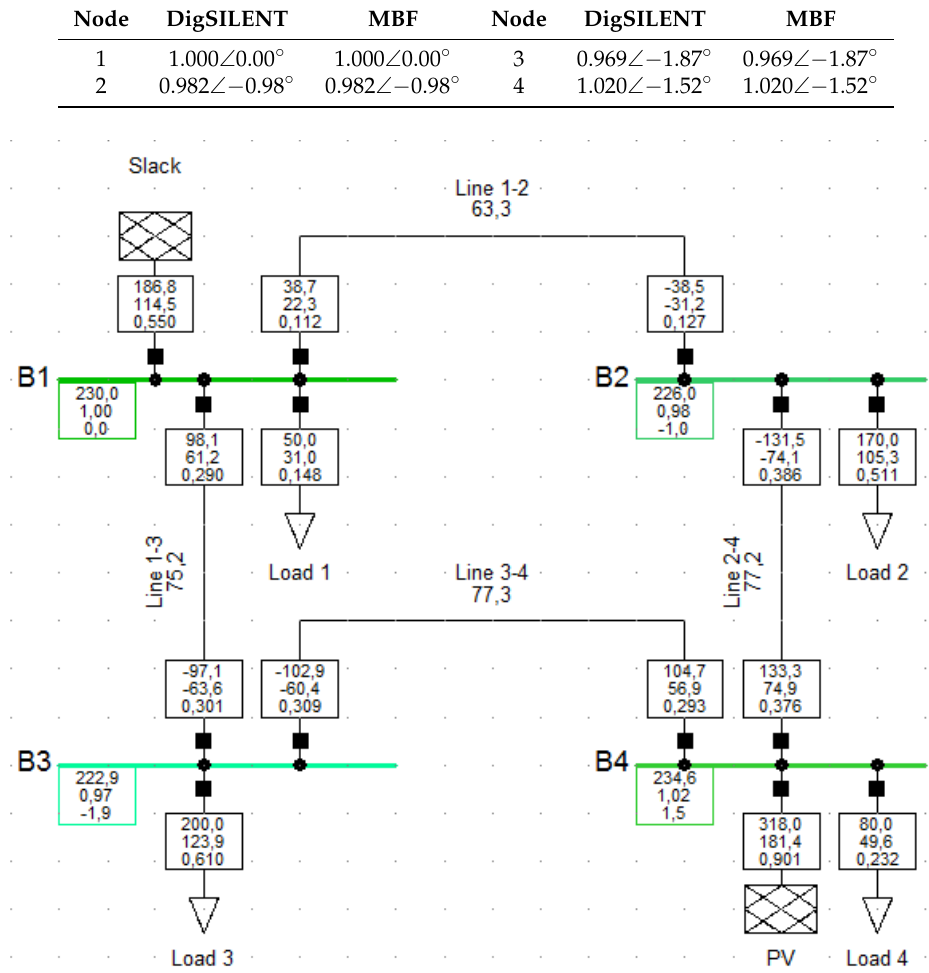
Figure 9. Electrical configuration of the four-node test